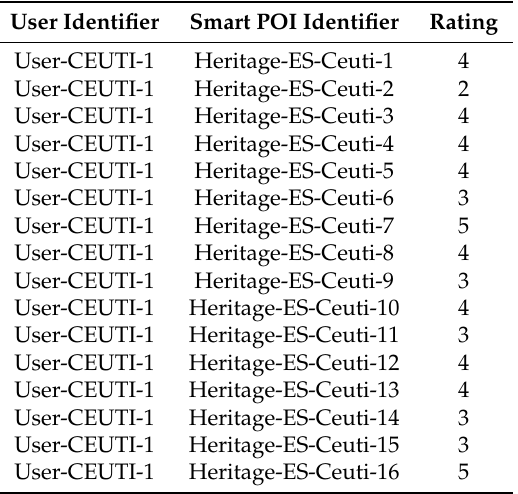
Table A2. User preferences dataset: example of structure for each